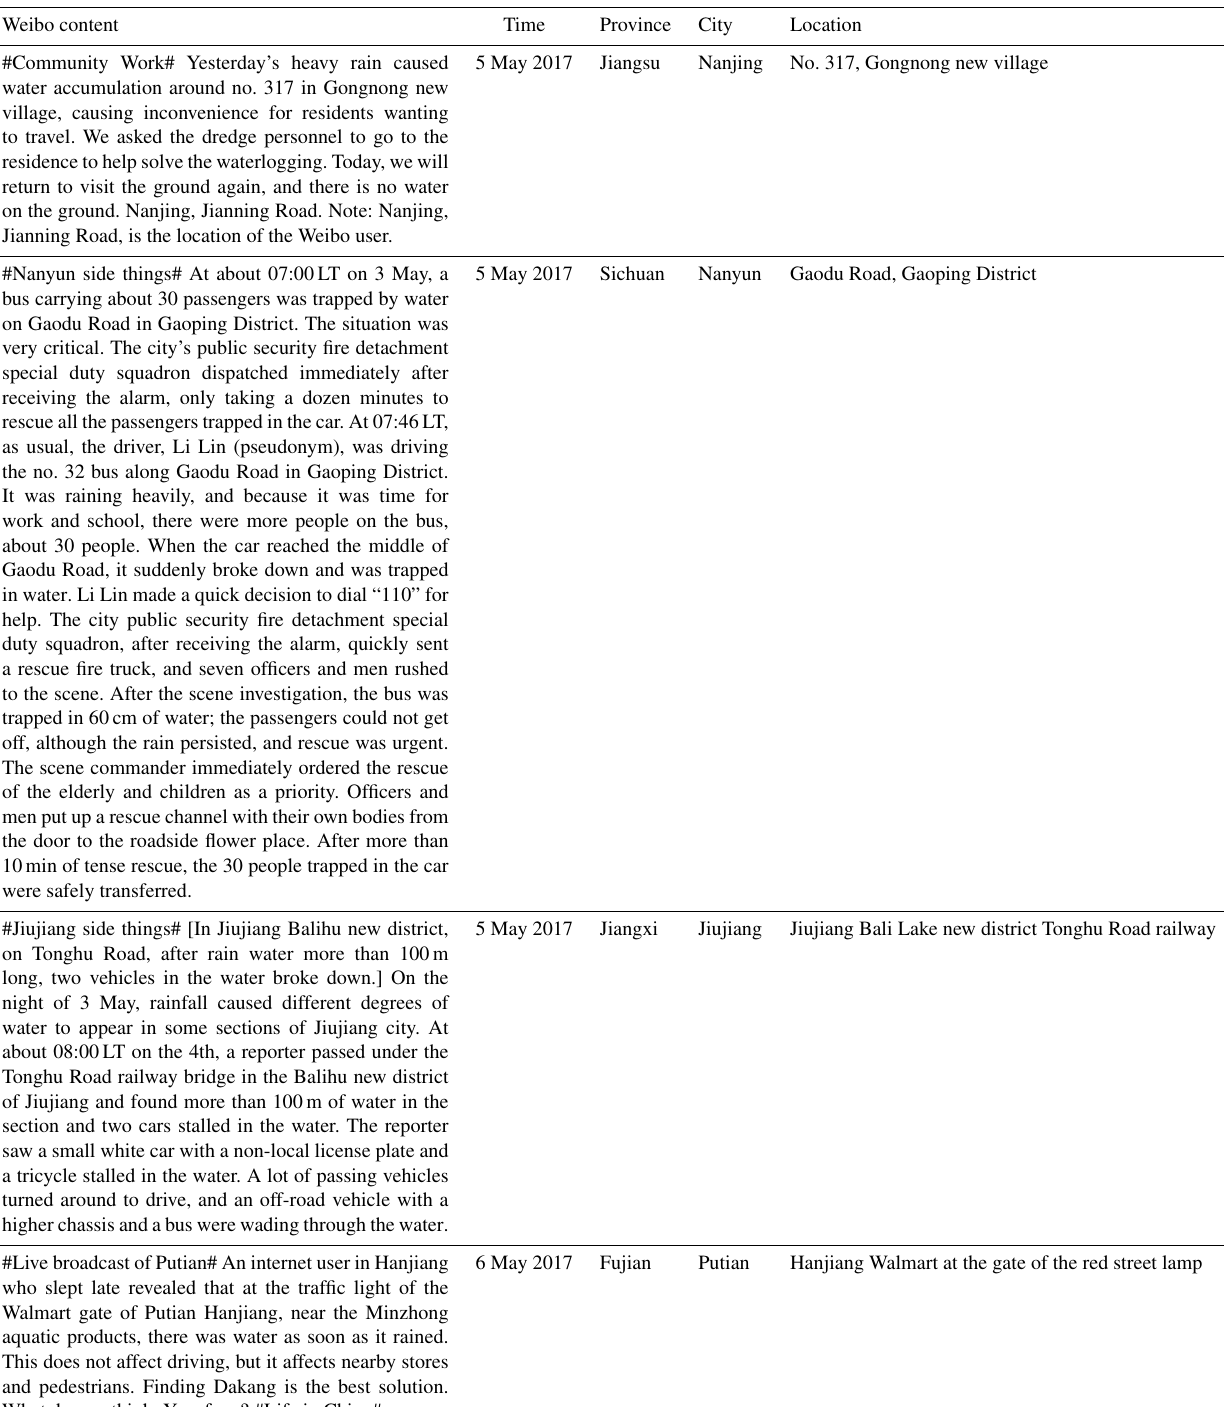
Table 1. Examples of Weibo posts related to urban flood deposits. Weibo content Time Province City